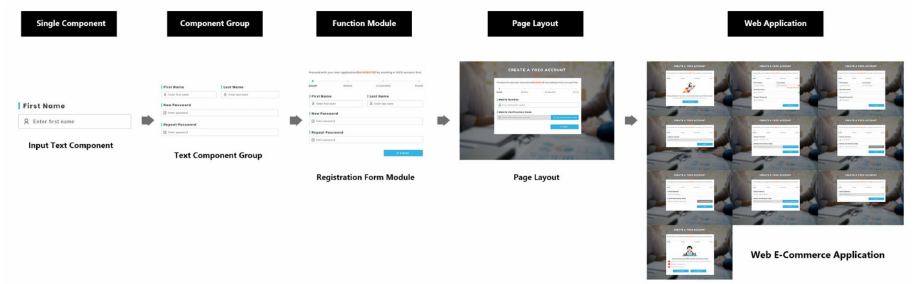
Figure 2. Web component